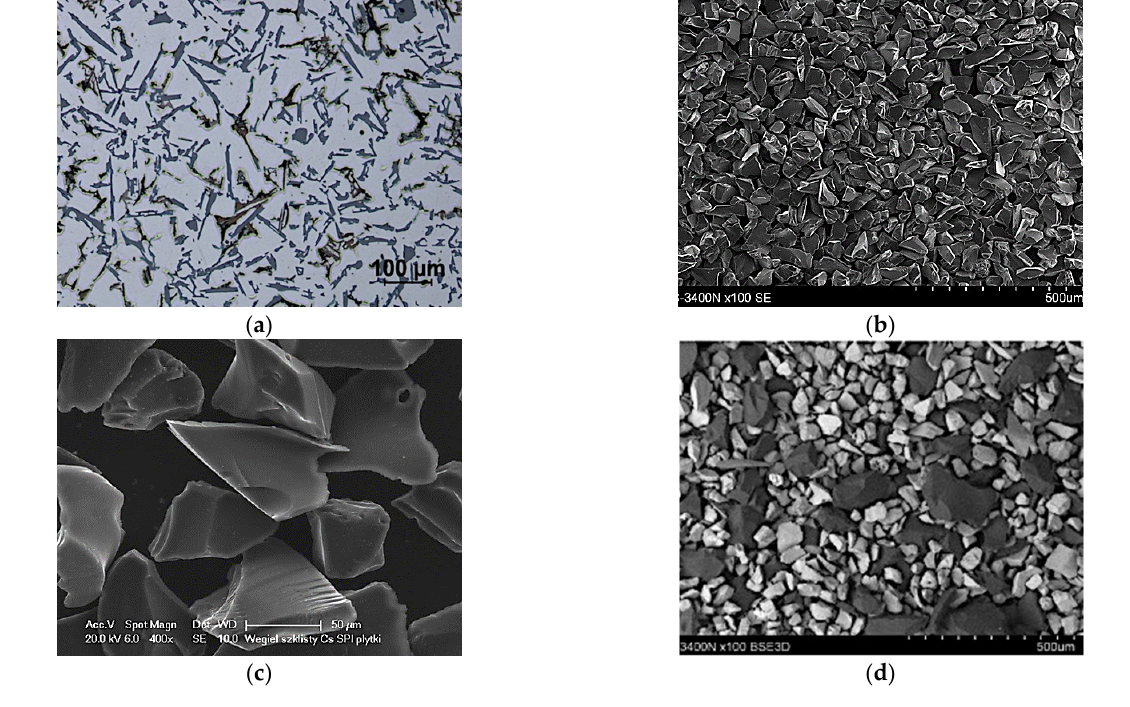
Figure 4. Microstructure of the base AlSi12 matrix alloy and the morphology of ceramic reinforce- ment: ( a ) AlSi12CuNiMg, LM; ( b ) silicon carbide (SiC p ), SEM; ( c ) glassy carbon (GC p ), SEM; and ( d ) SiC p + GC p hybrid powder mixture, SEM.